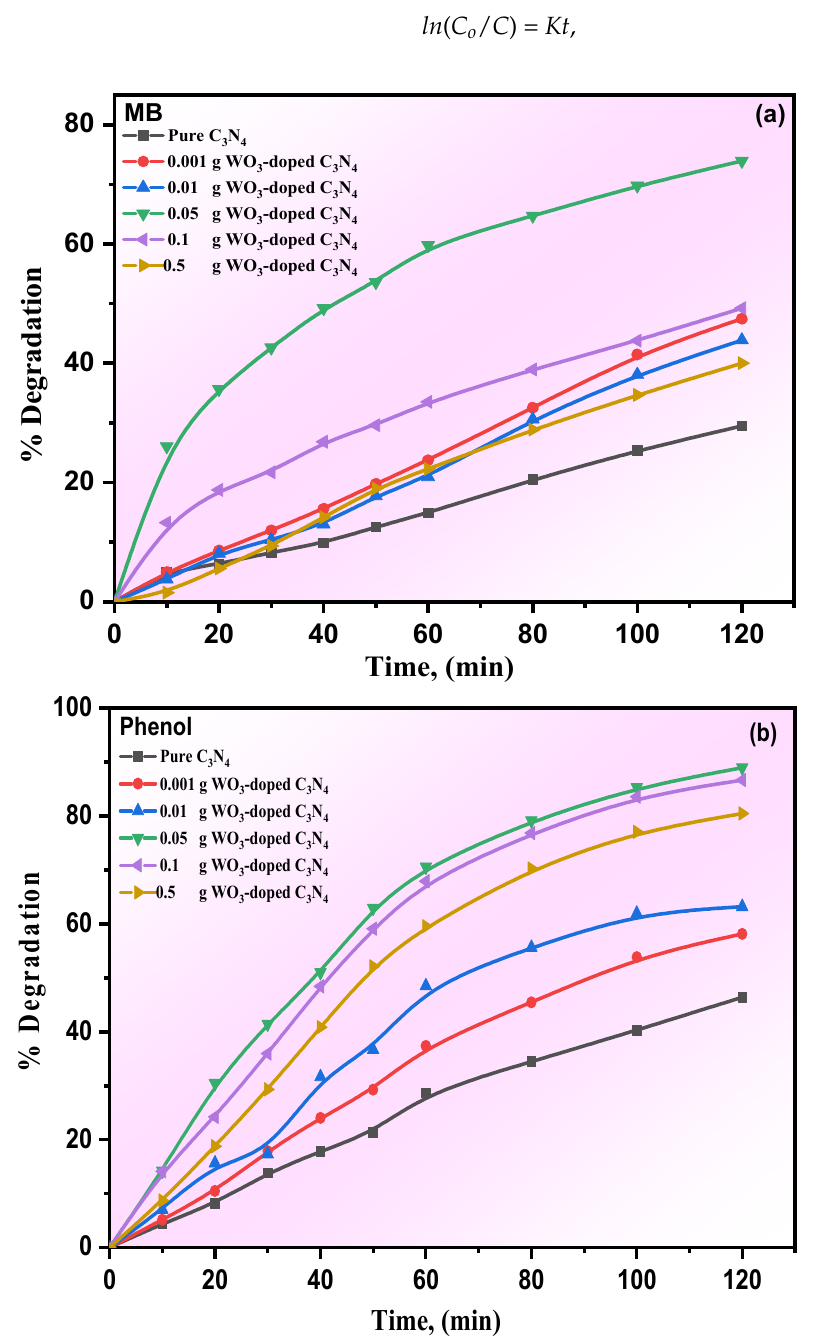
Figure 4. The degradation (%) of MB ( a , b ) phenol for pure g-C 3 N 4 and its WO 3 /g-C 3 N 4 nanocompo-